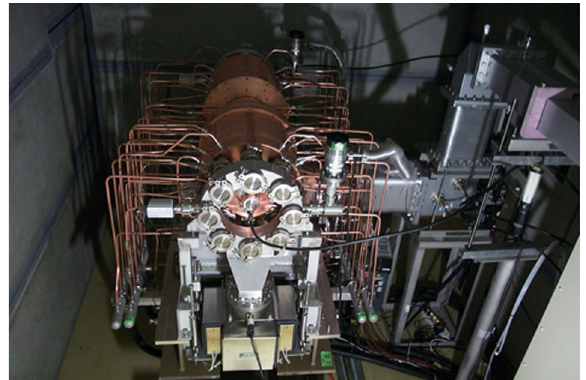
FIG. 11. ACS buncher module installed in the high-power-test